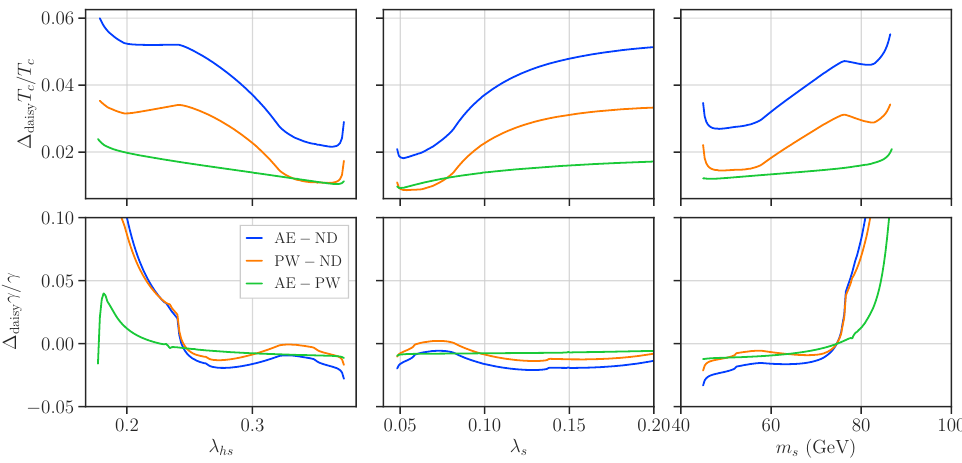
Figure 10 . Differences in critical temperature and transition strength with different methods for resummation of daisy diagrams, in the MS scheme of ξ = 0 and Q = m adding daisy resummation using the Parwani method and the Arnold-Espinosa method respectively, while ‘ND’ indicates no resummation of daisy diagrams. In each of the panels we vary one input parameter about the benchmark point in eq.